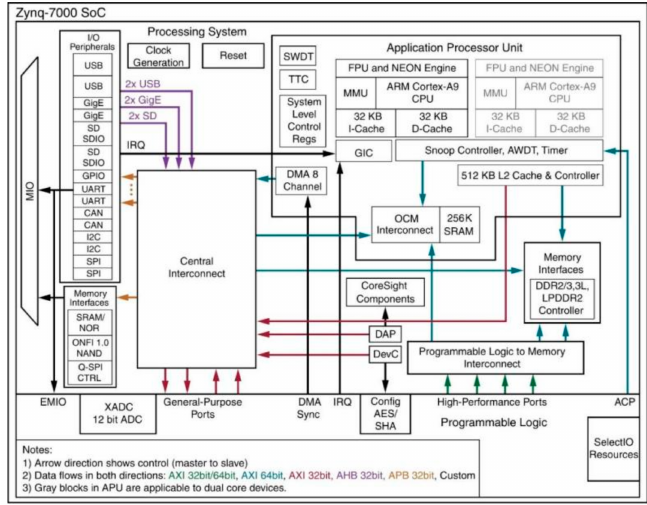
Figure 1. Overview of zynq7000